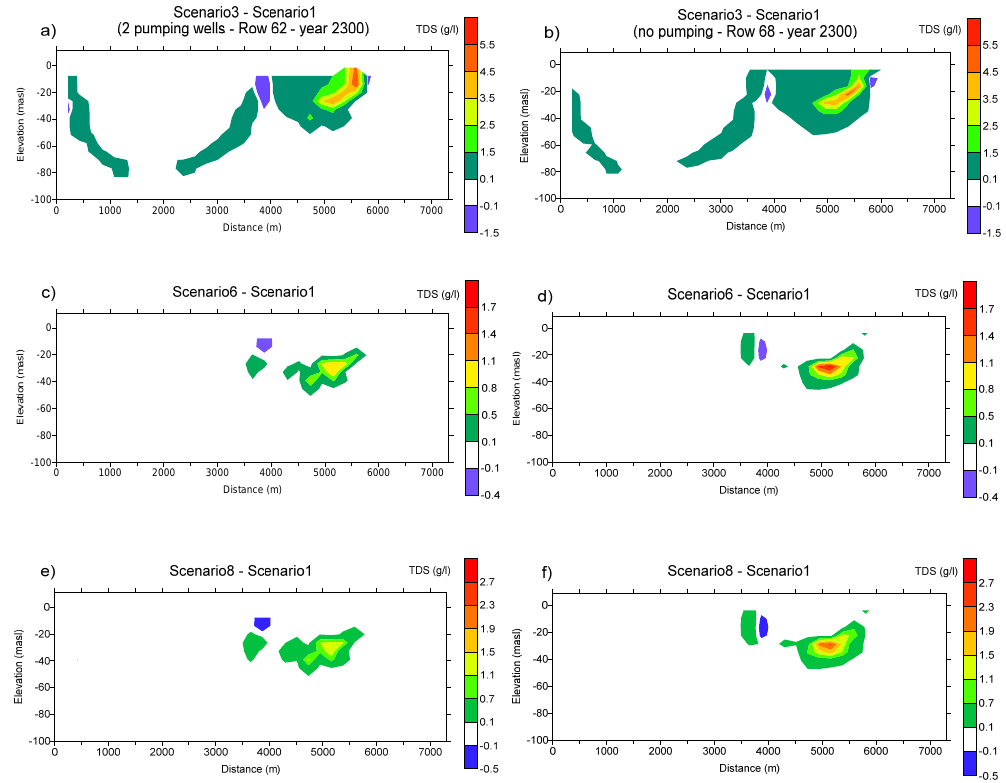
Fig. 13. Difference in simulated freshwater-saltwater distribution in 2300 (scale TDS (gL − 1 ) ), (a) scenario 3–scenario 1, cross section with pumping wells (row 62), (b) scenario 3–scenario 1, cross section with no pumping (row 68), (c) scenario 6–scenario 1, cross section with pumping wells (row 62), (d) scenario 6–scenario 1, cross section with no pumping (row 68), (e) scenario 8–scenario 1, cross section with pumping wells (row 62), (f) scenario 8–scenario 1, cross section with no pumping (row